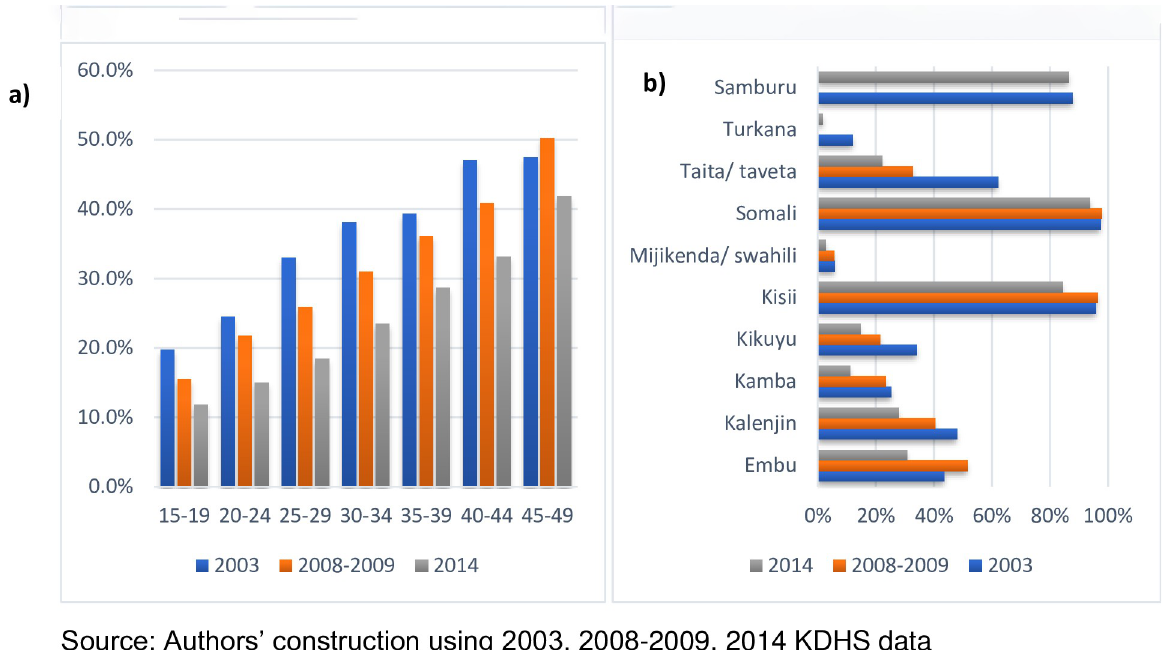
Fig 1. Graphs showing FGM/C prevalence in Kenya, 2003 to 2014. Shows FGM/C prevalence computed using 2003, 2008–2009 and 2014 demographic health surveys data. a) Shows the overall FGM/C prevalence in Kenya from 2003 to 2014. b) shows the distribution of FGM/C prevalence by Kenyan